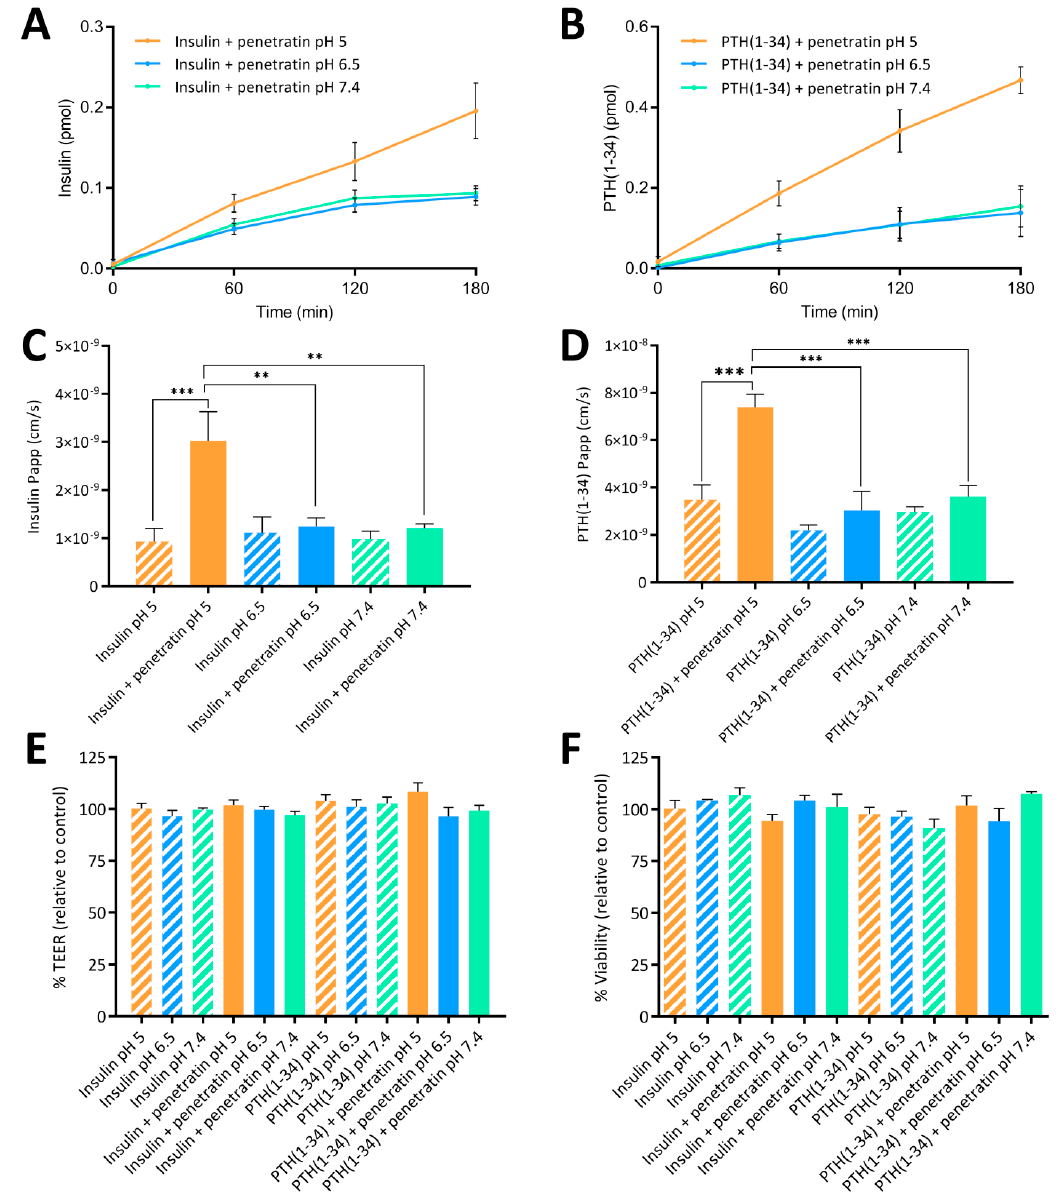
Figure 5. Permeation of insulin ( A ) or PTH(1 ‐ 34) ( B ) across Caco ‐ 2 monolayers following